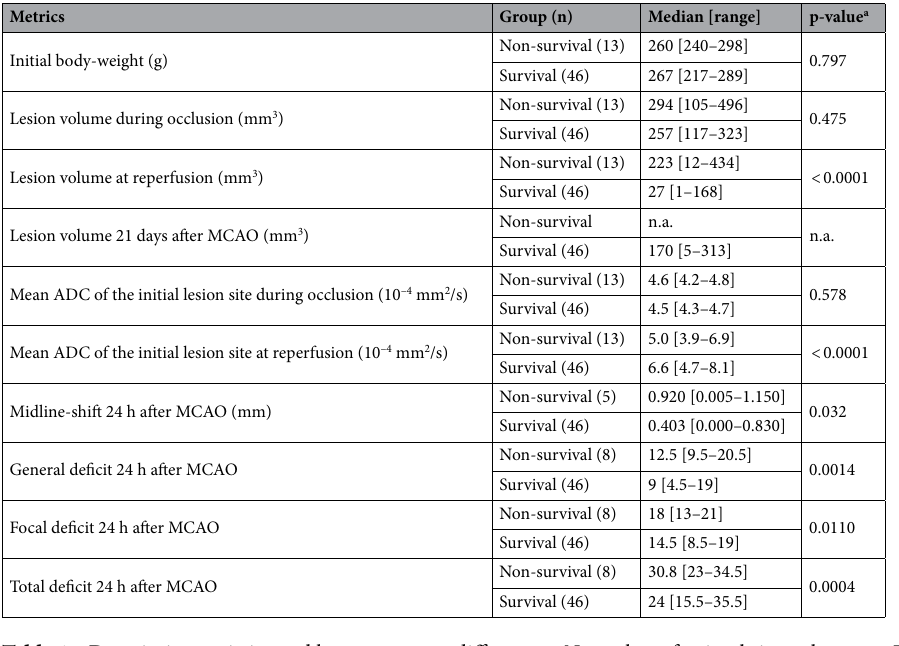
Table 1. Descriptive statistics and between group differences. N number of animals in each group, Initial body-weight body-weight right before left middle cerebral artery occlusion (MCAO) surgery, ADC apparent